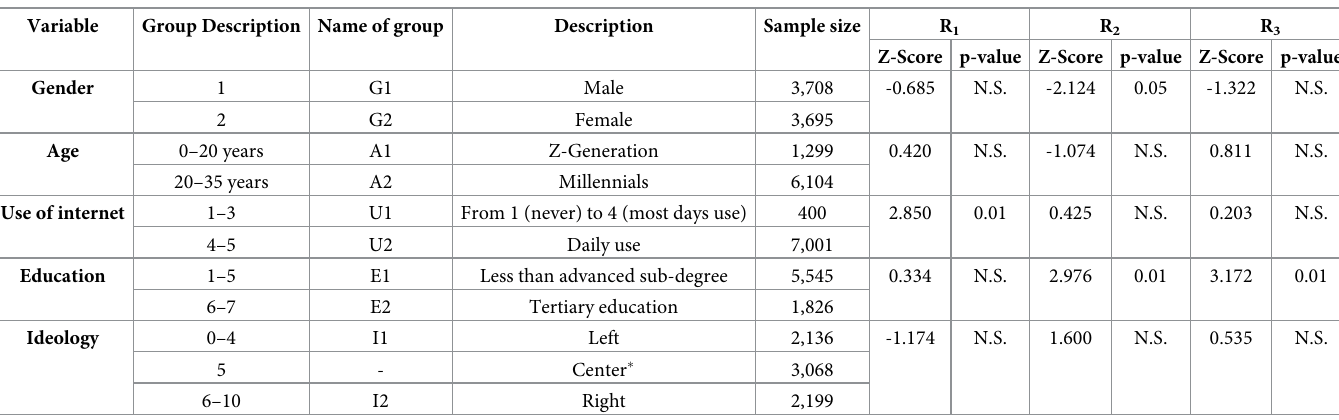
Table 6. Groups definitions.